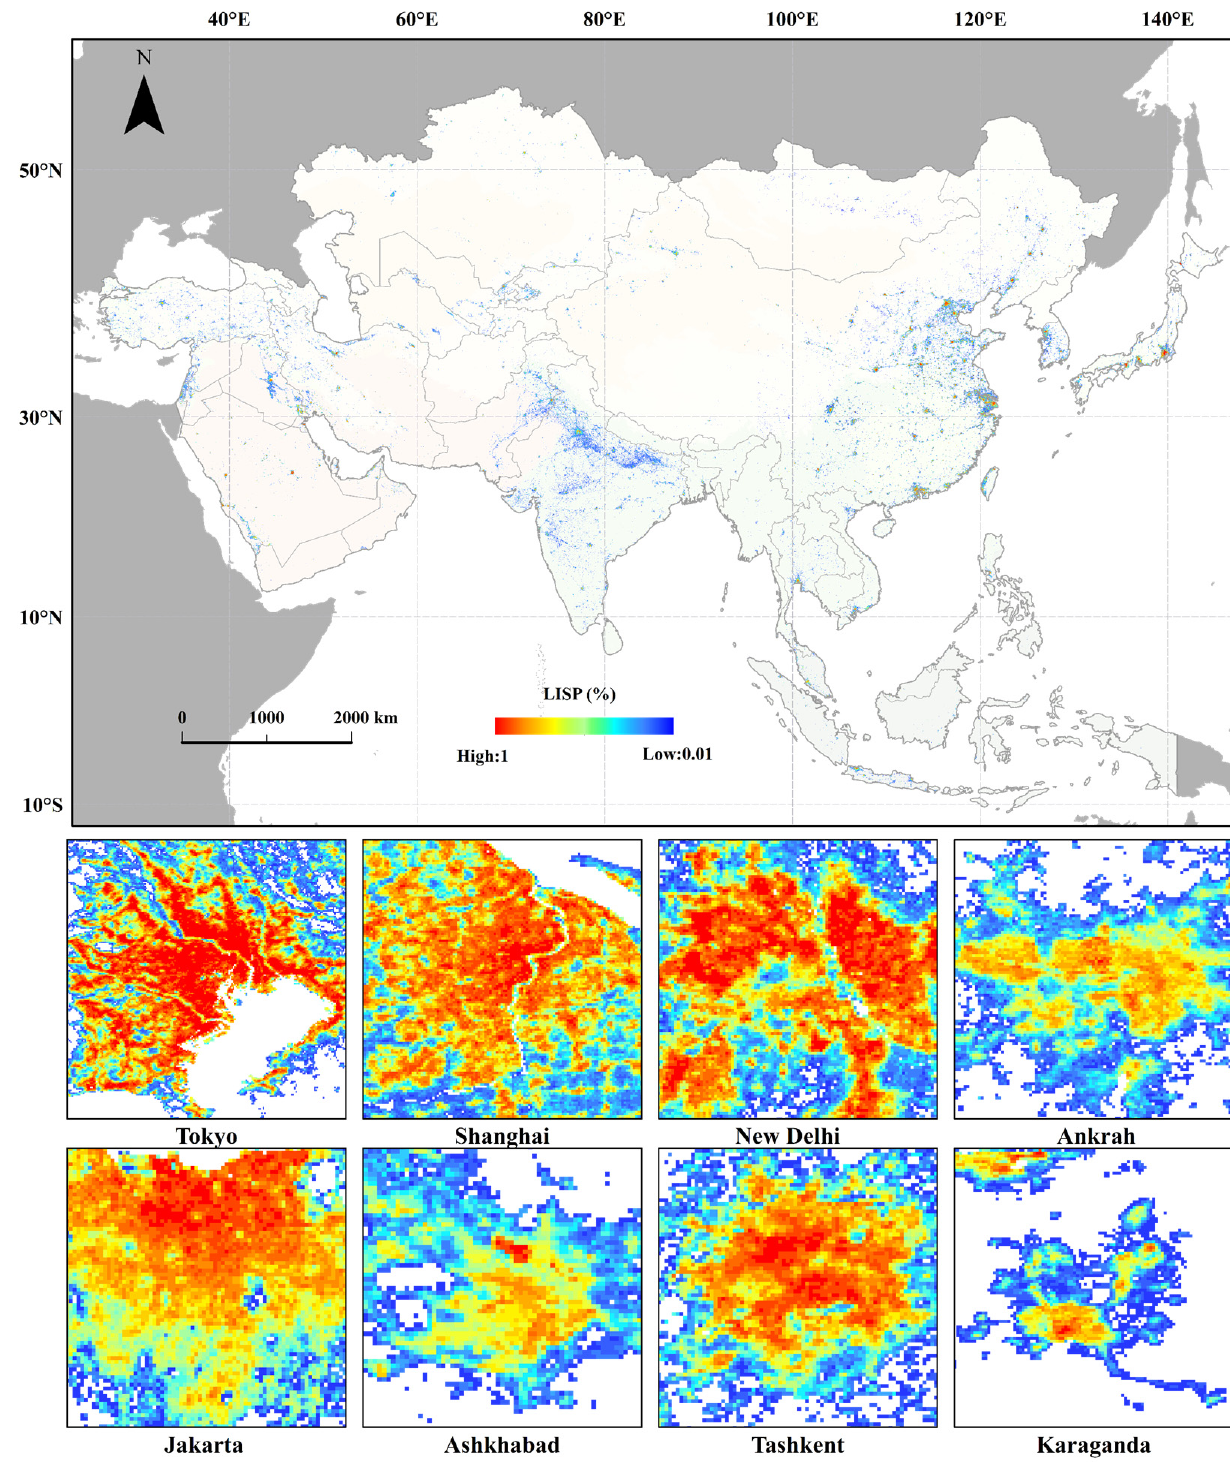
Figure 8. Large-scale impervious surface percentage (LISP) map in Asia.